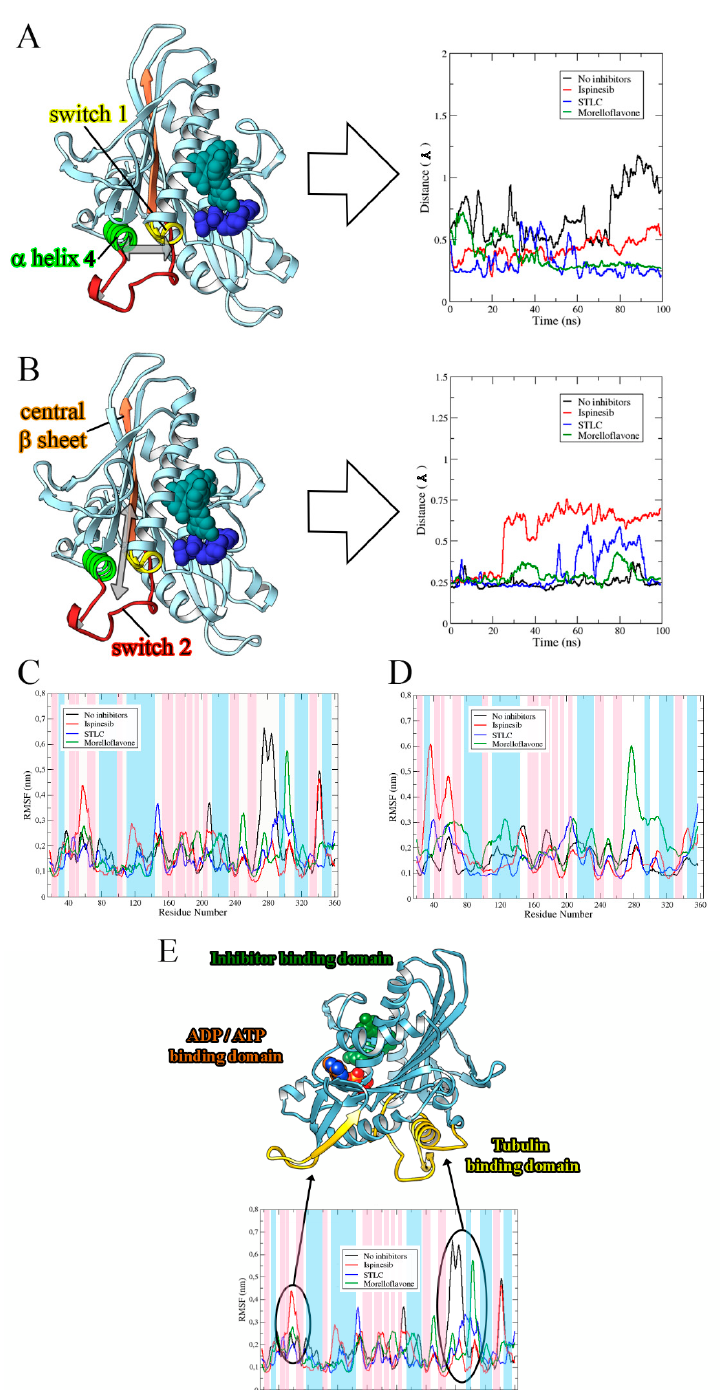
Figure 6. Structural behavior of Eg5 in the presence and absence of inhibitors. Distance of ( A ) switch I from α 2-helix and ( B ) switch II from the central β -sheet. Graphs are shown as Eg5 without inhibitors (black), with ispinesib (red), with STLC (blue), and with MF (green). Inhibitor (sphere, cyan) is bound to the allosteric pocket whereas the nucleoside-phosphate (sphere, blue) complexed with Eg5 at the ATP/ADP-binding site. The estimated distance between selected Eg5 segments plotted for STLC and MF are similar. RMSF profiles of ( C ) ADP-bound Eg5 complexes and ( D ) ATP-bound Eg5 complexes. ( E ) Fluctuations in Eg5 regions induced by MF. The β -sheets, α -helices, and loops of secondary structure are highlighted in blue, pink, and white,